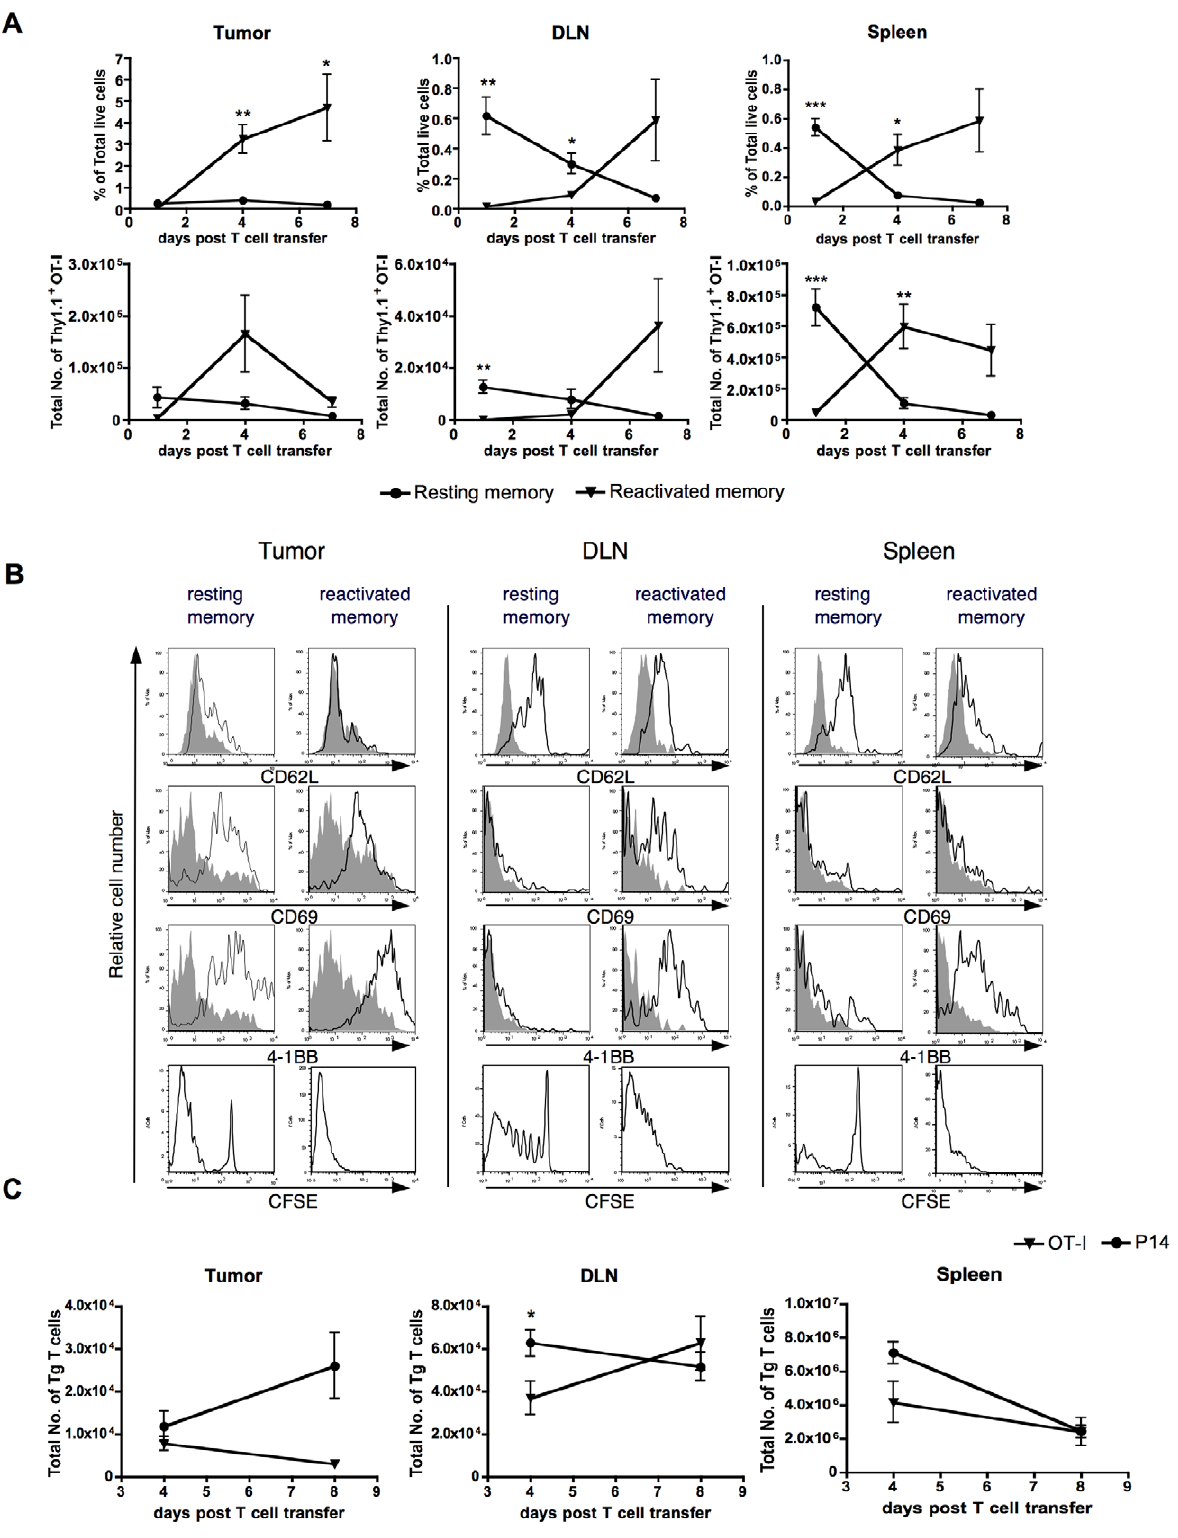
Figure 3. Analysis of memory OT-I cells after adoptive transfer into tumor bearing animals. C57BL/6 mice were inoculated s.c. with E.G7 tumor cells on day 0. On day 8, resting memory or reactivated memory OT-I cells were transferred into tumor bearing mice. On day 1, 4, or 7, mice were sacrificed and OT-I Thy1.1 cells were enumerated in the tumor, draining lymph node (DLN) and spleen. (A) The percentage of OT-I resting memory and reactivated memory cells was determined according to gated CD8 + Thy1.1 + cells over the total number of living cells. The OT-I cell number was obtained by multiplying the percentage by the total cell count of the organ. A summary of two independent experiments is shown. (B) Histograms show the expression of CD62L, CD69 and 4-1BB (open area) overlaid on the background staining with antibody isotype controls (shaded